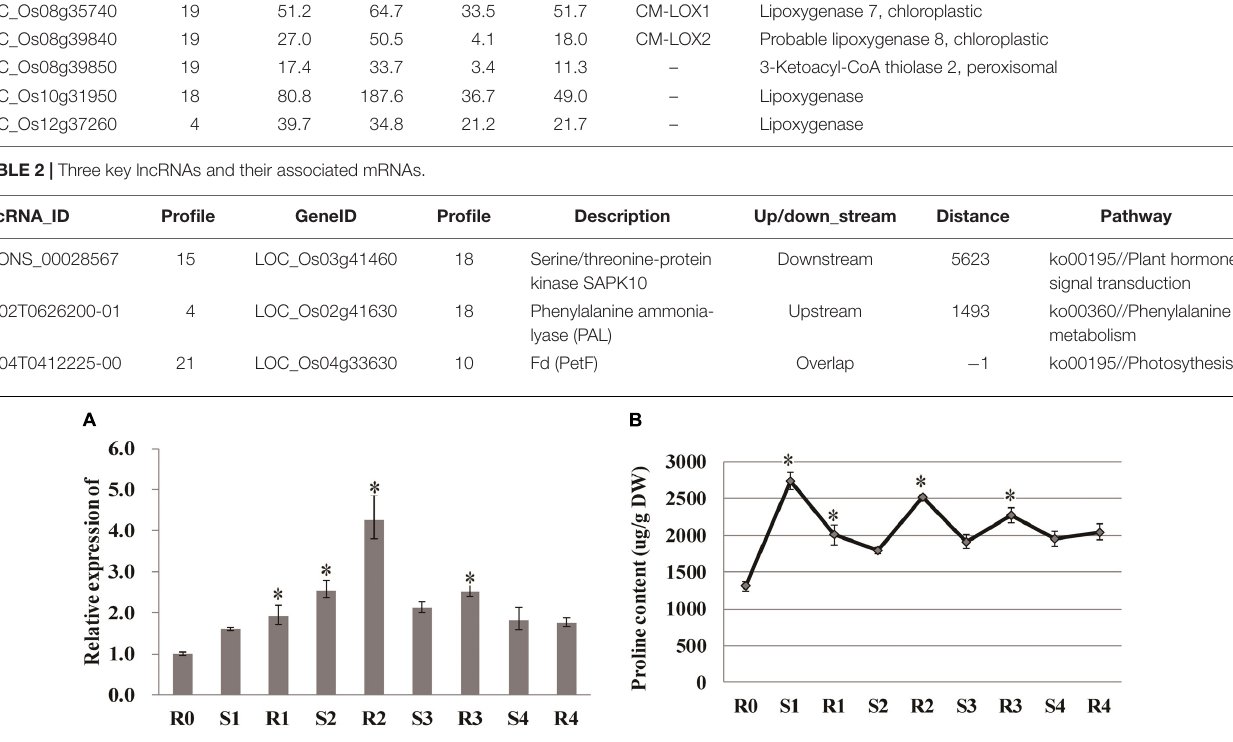
FIGURE 6 | Analysis of proline and P5CS1 . (A) qRT-PCR analysis of P5CS1 (LOC_Os01g62900). (B) Proline content under stress treatment. Data are means of three biological replicates and error bars are ± SE from three independent experiments, each performed with 6–8 leaves from five separate plants. Asterisks indicate significant differences by Tukey LSD test ( ∗ P <